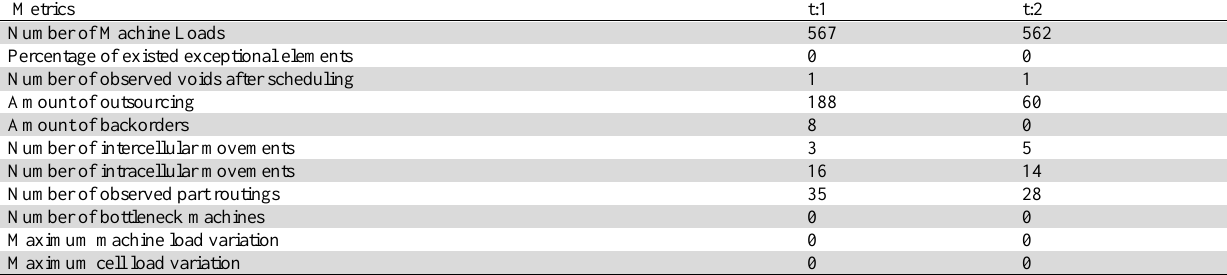
Results of analyzing best observed layout for experiemnt number 1